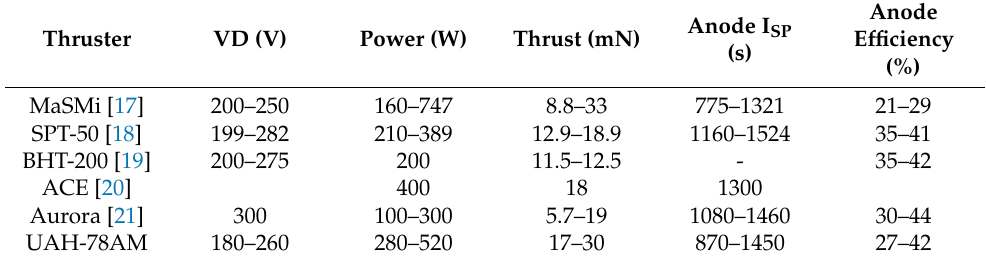
Table 3. Comparison of Thrusters in the UAH-78AM Power Class at Similar Discharge